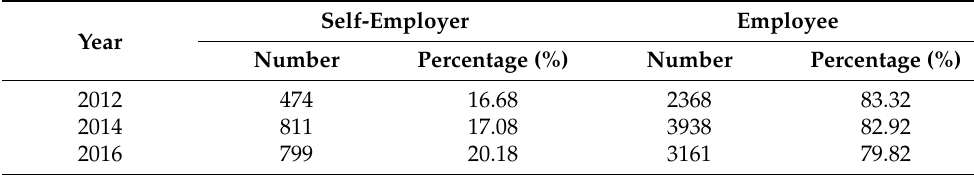
Table 1. Distribution of the sample between the self-employed and